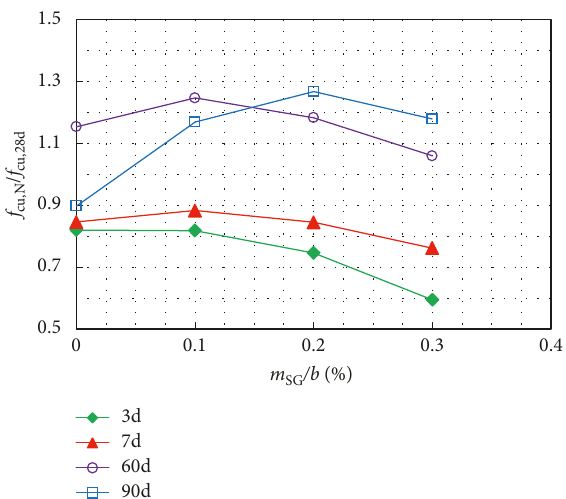
Figure 7: Effect of (m) SG /(b) on (f) cu,N /(f) cu,28d.